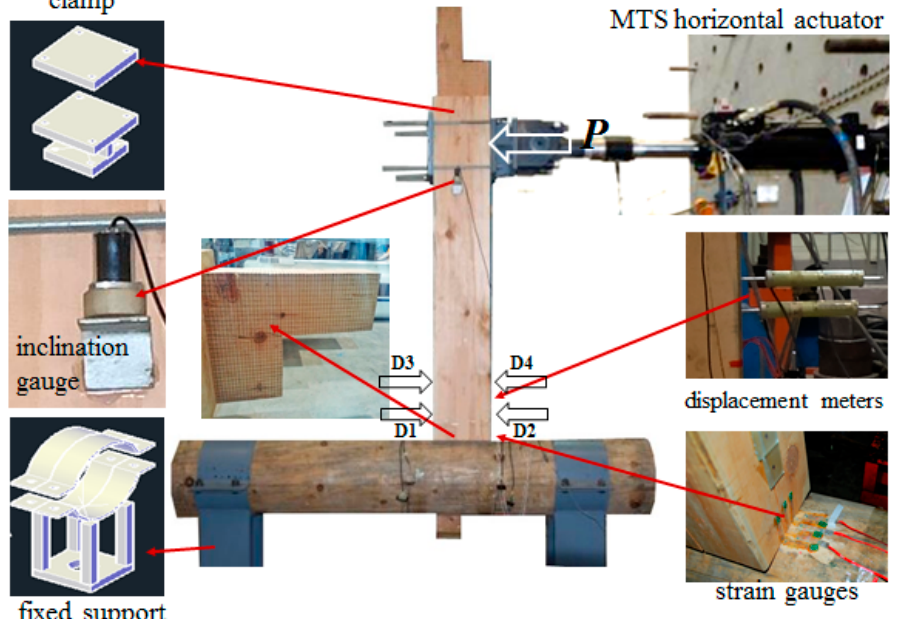
Figure 15. Test setup and loading programme.